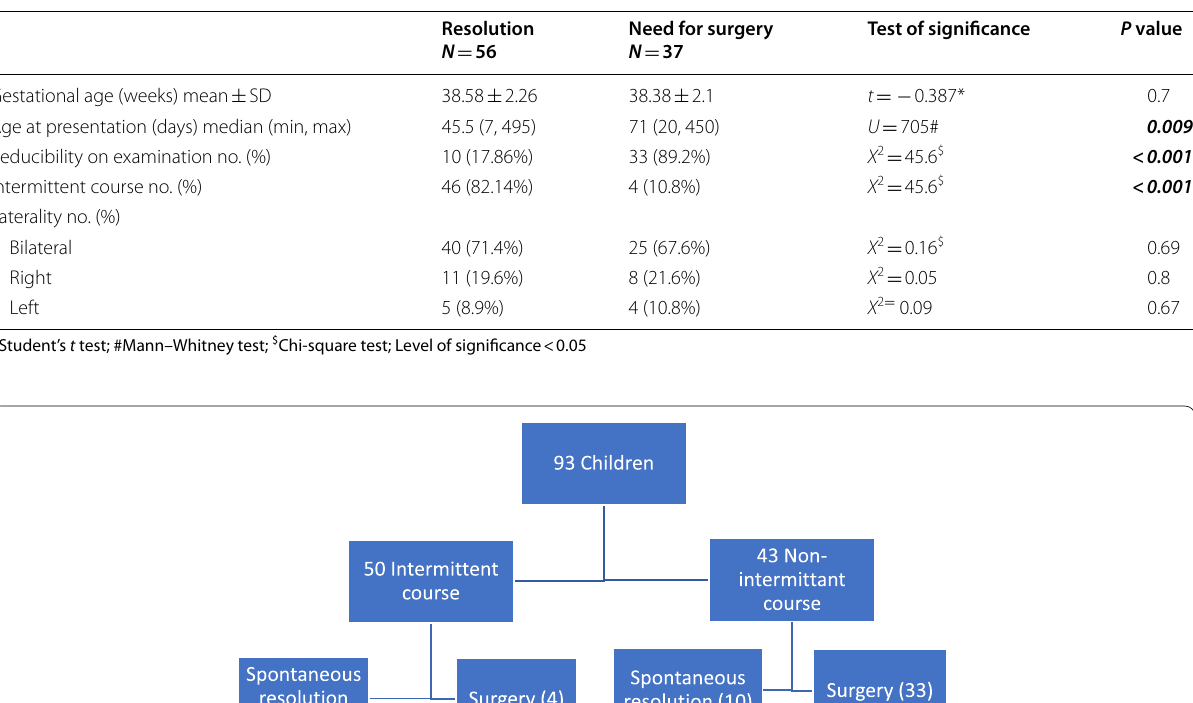
Table 3 Risk factors for non-response to watchfulness